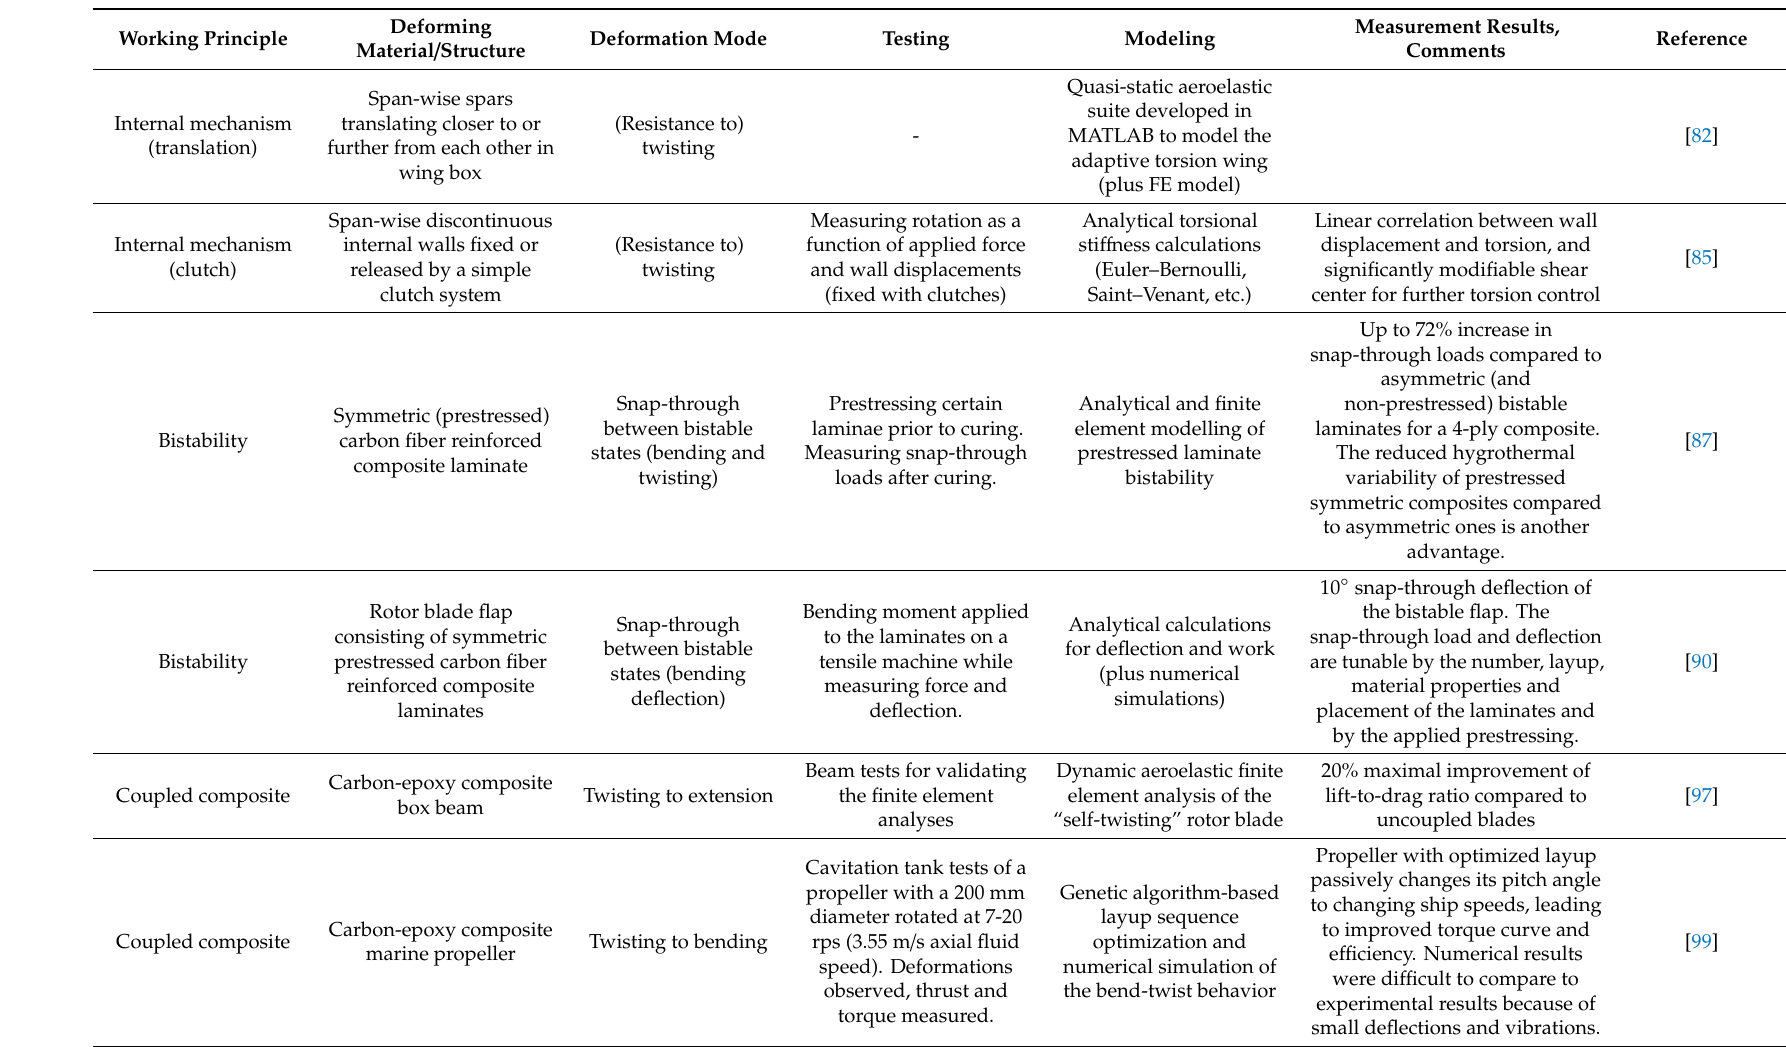
Table 3. Mechanically actuated non-conventional